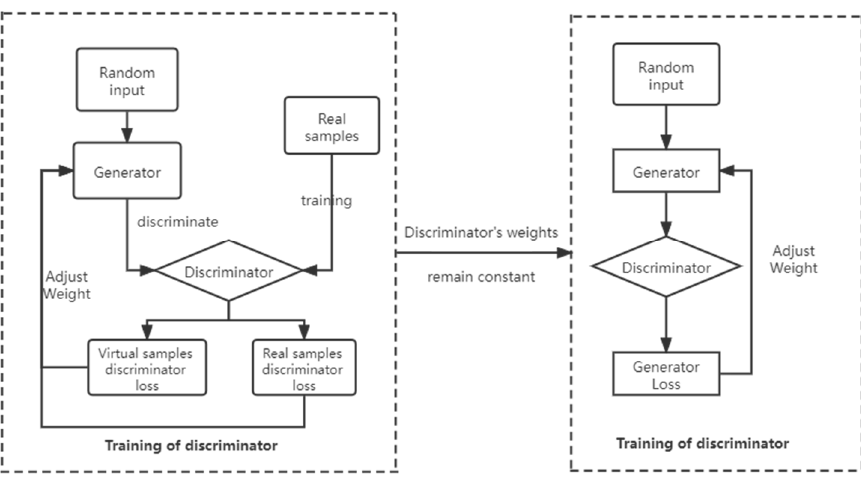
Figure 2. The training flow and architecture of